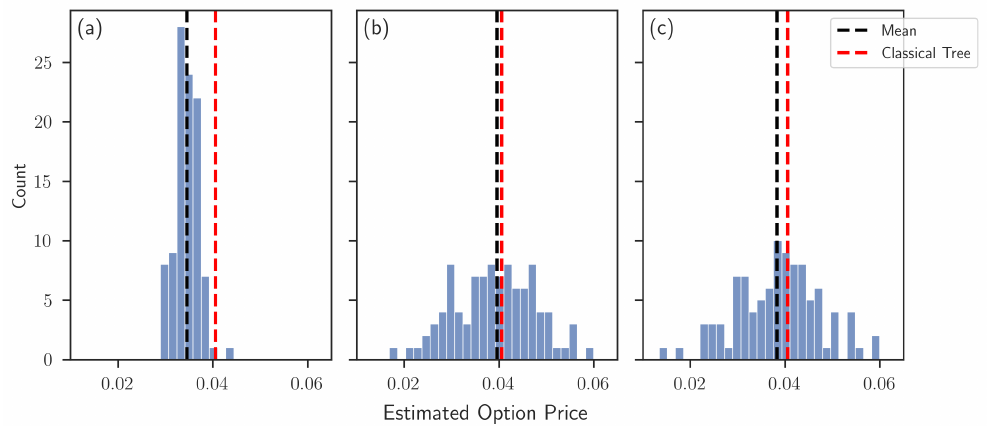
Figure 6. Histograms of quantum simulator results for full pricing algorithm with state register in uniform superposition, i.e., simultaneous computation of all paths for n = 5 time steps, gearbox ap- proximation levels D and terms in the Fourier expansion n f : ( a ) D = 1, n f = 4, ( b ) D = 2, n f = 5, and ( c ) D = 2, n f = 8. 100 circuit results are presented, where each result consists of 10 6 circuit executions.